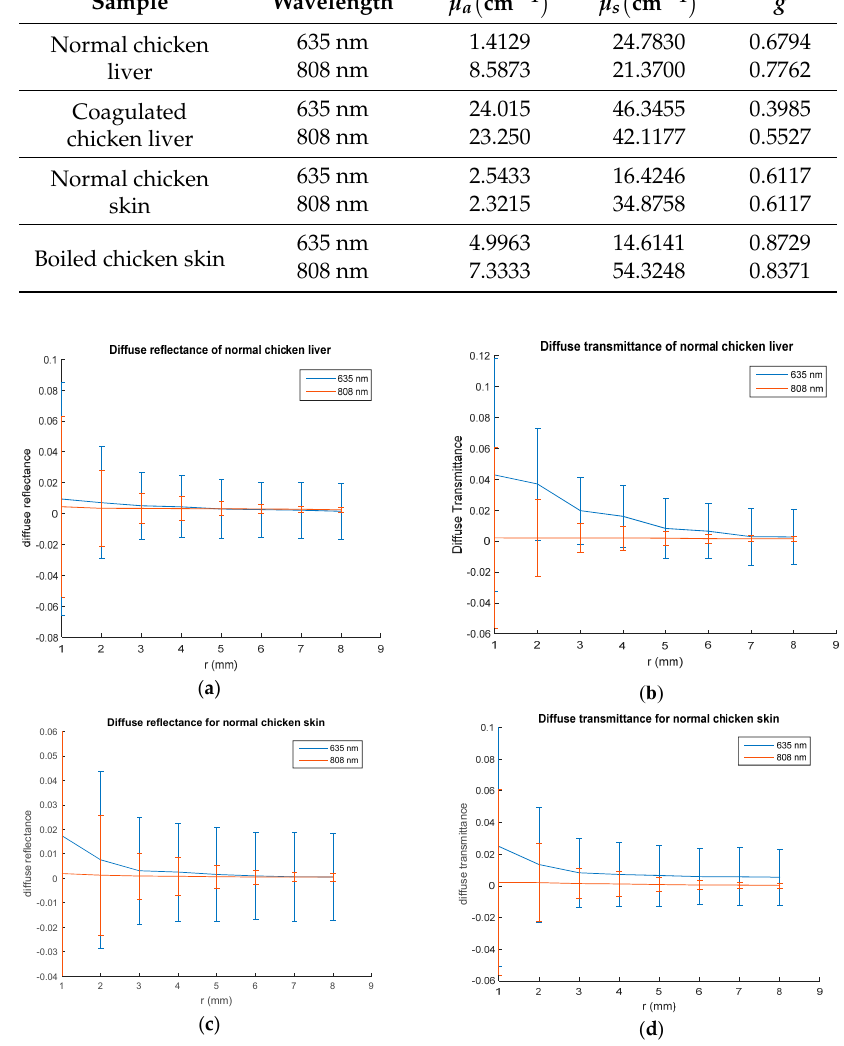
Table 1. The calculated optical parameters.